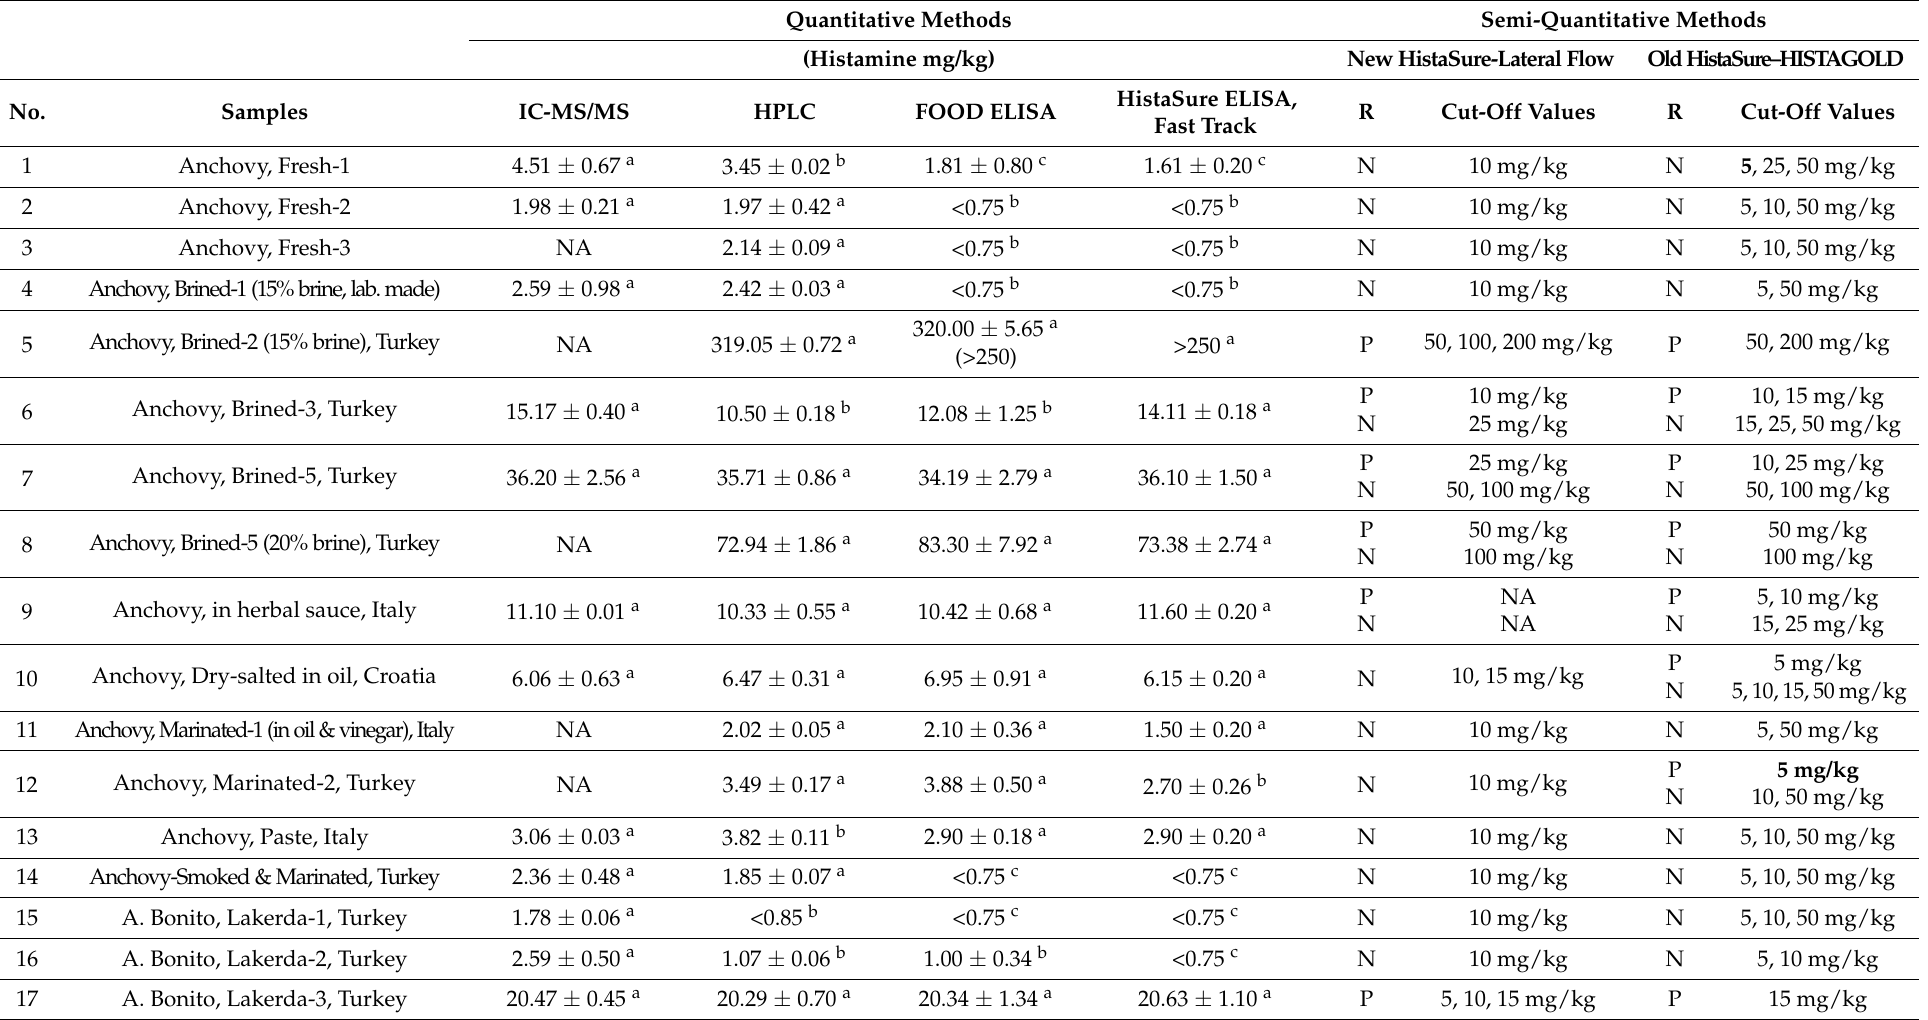
Table 1. Histamine values (mg/kg) of various fish products analyzed by 4 quantitative (IC-MS/MS, HPLC, Food ELISA and HistaSure ELISA Fast Track) methods and 2 semi-quantitative test